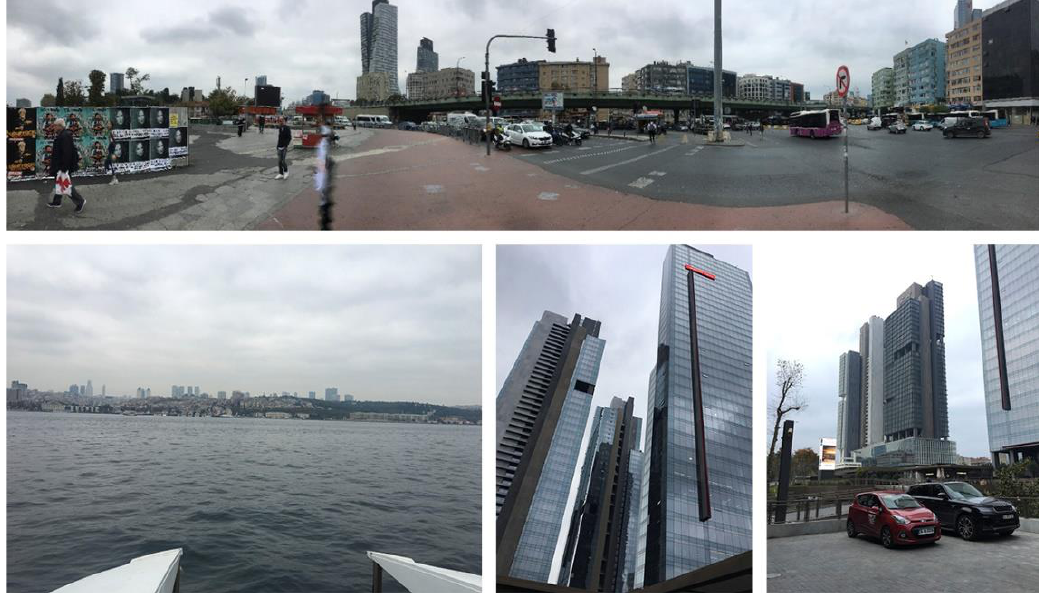
Figure 6 View of Mecidiyeköy from Üsküdar ferry and the financial and trade centers in Mecidiyeköy (Photograph credits: personal archive of Feride Gül Keleş and Uzay Topal, 2019)